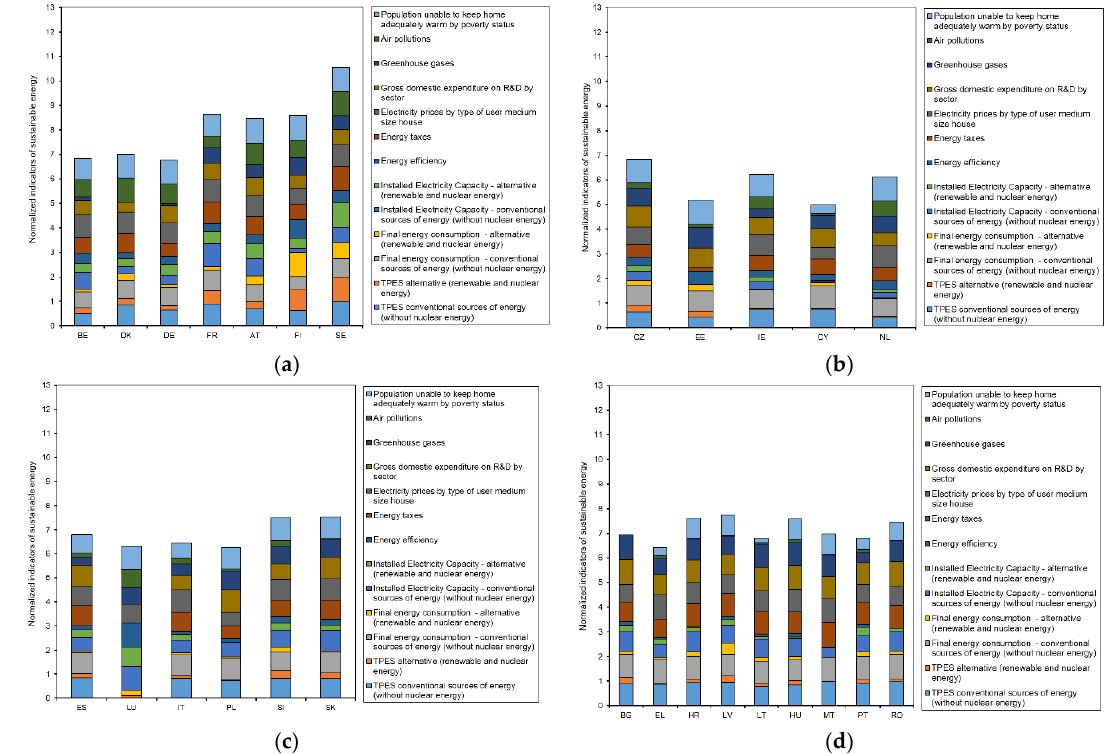
Figure 11. Sustainable energy development profiles in relation to the population size of the EU countries in particular groups (( a )-cluster 1, ( b )-cluster 2, ( c )-cluster 3, ( d )-cluster 4).